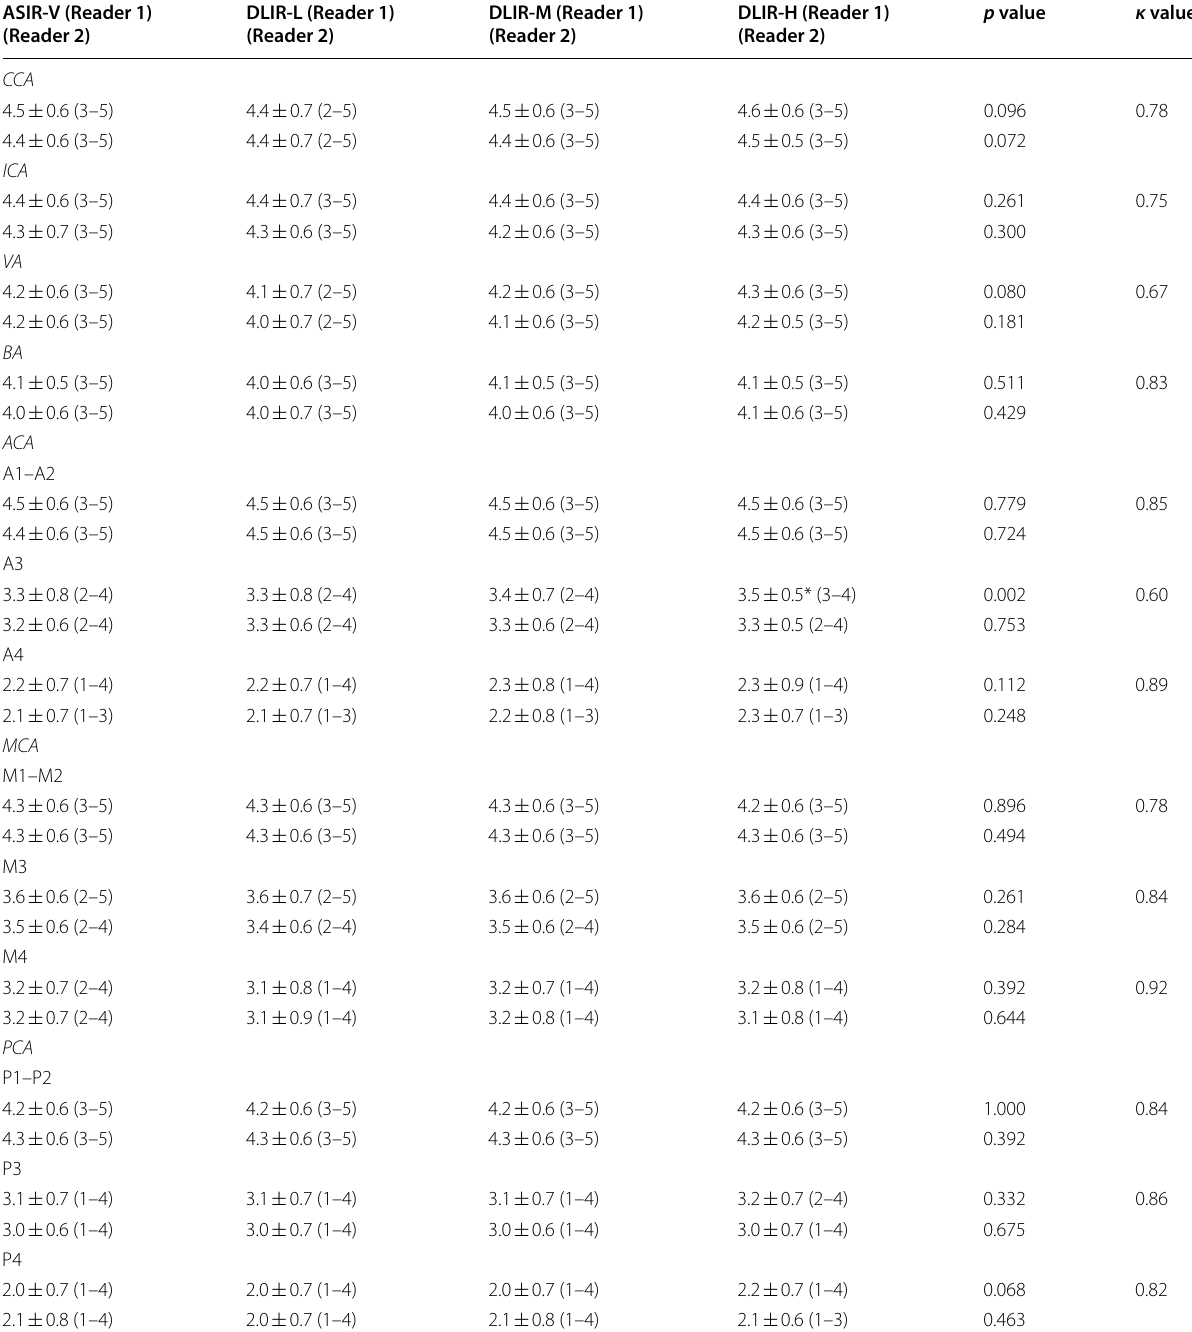
Table 2 Arterial depiction on four reconstructed